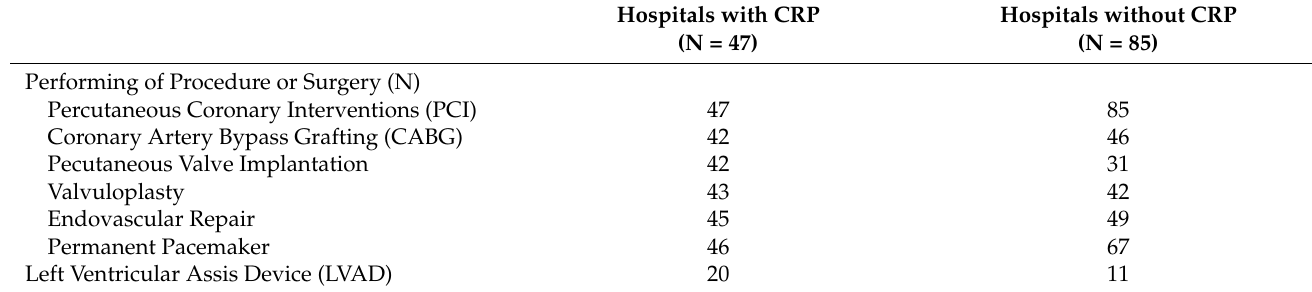
Table 2. The general characteristics between the hospital with and without cardiac rehabilitation programs